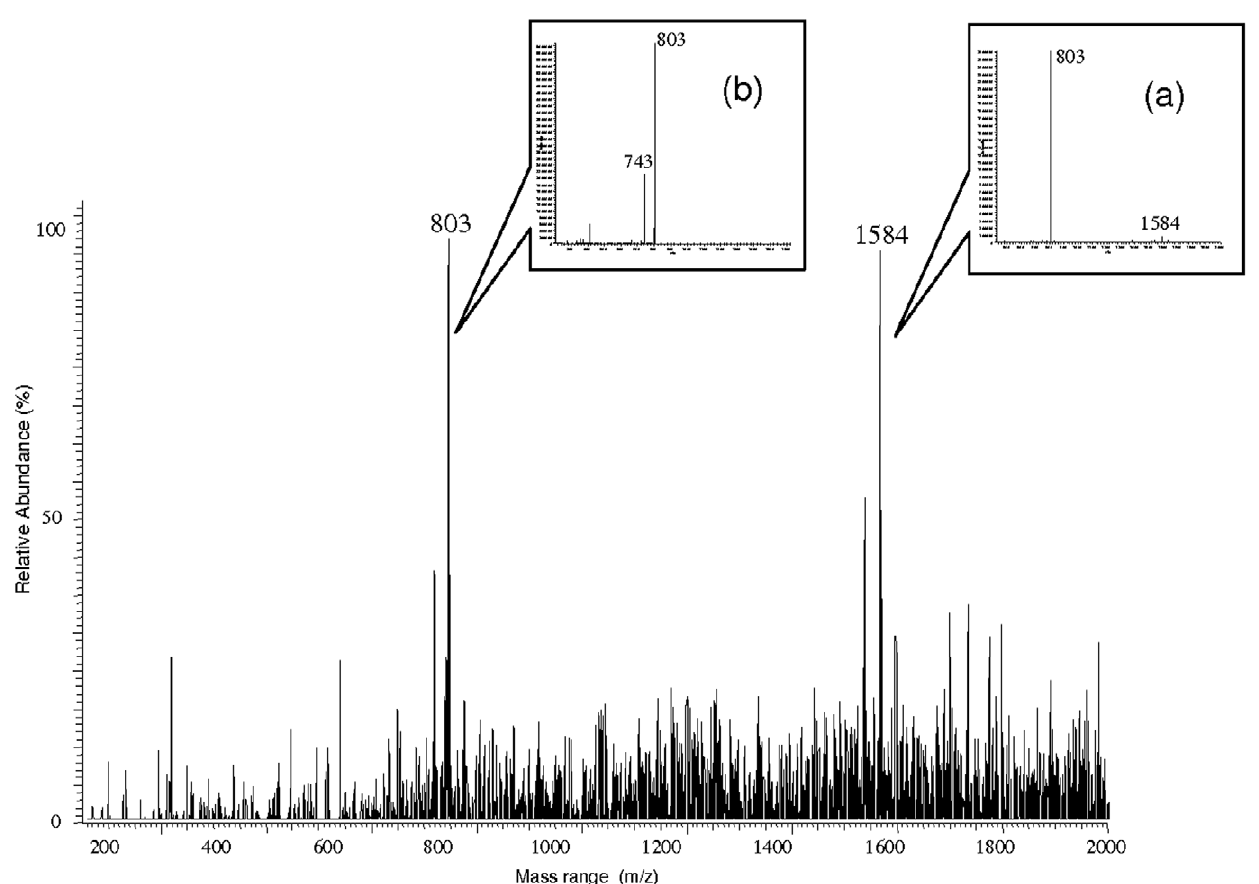
Figure 3. Mass spectra collected as total ion current (TIC) from the direct infusion analysis of Dufour gland extracts from Crematogaster striatula (positive mode ESI-MS). We can see two major peaks at m/z 1584 and 803. (a) MS-MS of m/z 1584: the total fragmentation results only in the ion m/z 803, showing that this ion is a part of ion 1584. (b) MS-MS of the ion m/z 803: partial fragmentation with only the loss of 60 u (the loss of an acetyl radical) resulting in the ion m/z 743.